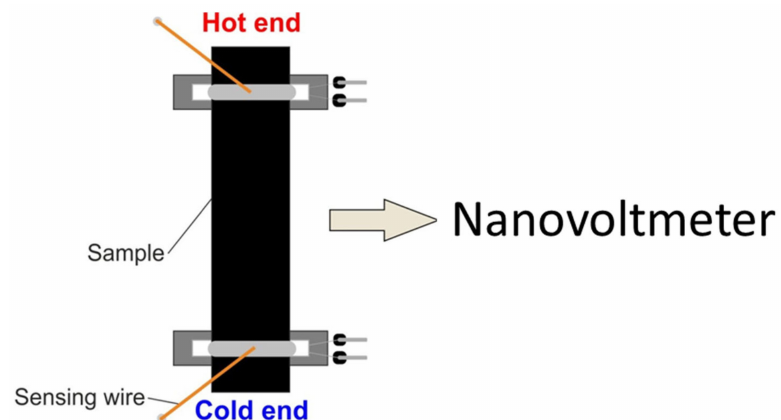
Figure 2. Measurement of the Seebeck coe ffi cient of carbon nanotube (CNT) films (not to scale).